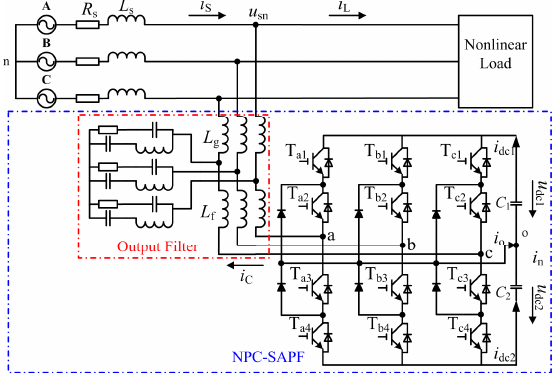
Figure 1. Configuration of the neutral-point-clamped shunt active power filter (NPC-SAPF) system.